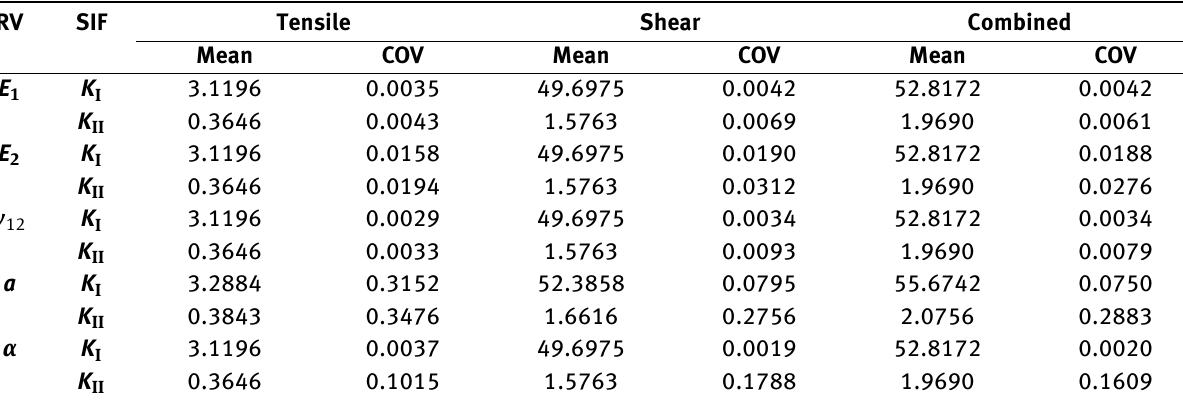
Table 3: Effect of individual random variables on the normalized mean and COV of K I and K I I of double edge cracked FGMs plate subjected to uniaxial tensile, shear and combined stresses